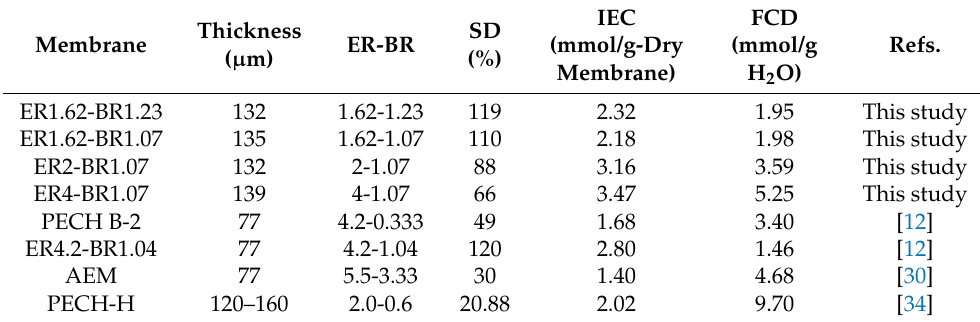
Table 4. Comparison of the results of this study with the literature data.